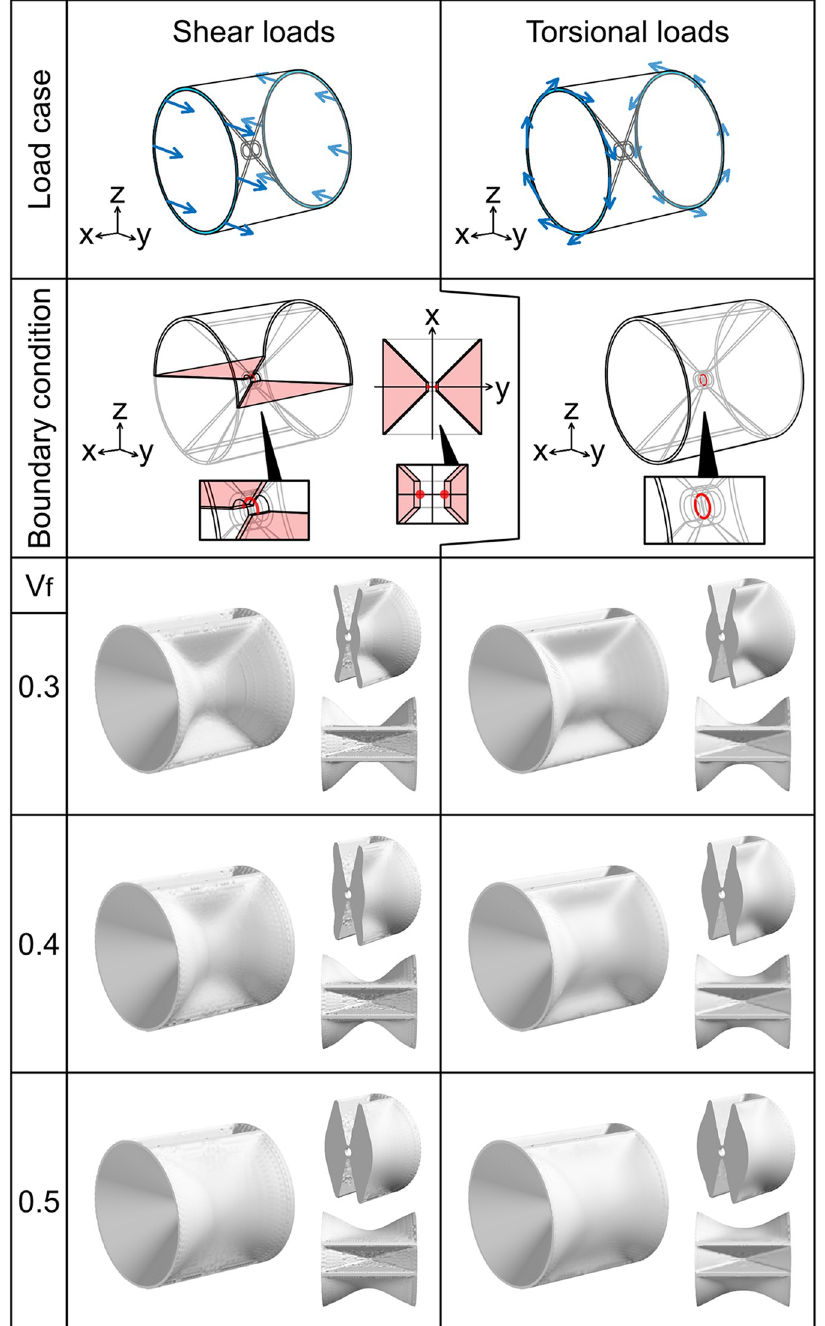
Fig 5. Optimization for shear and torsional loads to autocentrum. The arrangement and color scheme of the images are the same as those described in Fig 3. For the shear loads, we imposed the symmetric boundary condition u � n = 0 on the xy plane (left image in the second row from the top) and used a half model. The right diagram is the area to which the symmetric boundary condition is imposed on the xy plane. Magnified images of the center of the analysis domain are shown. We imposed two displacement constraints: u = 0 to the points (0, − C R , 0) and (0, C R , 0) (the red x dots), and u y = 0 to the edge y 2 + z 2 = C R2 ( z � 0, the red line). For the torsional loads, we imposed the displacement constraints u = 0 to the edge y 2 + z 2 = C R2 (the red line).